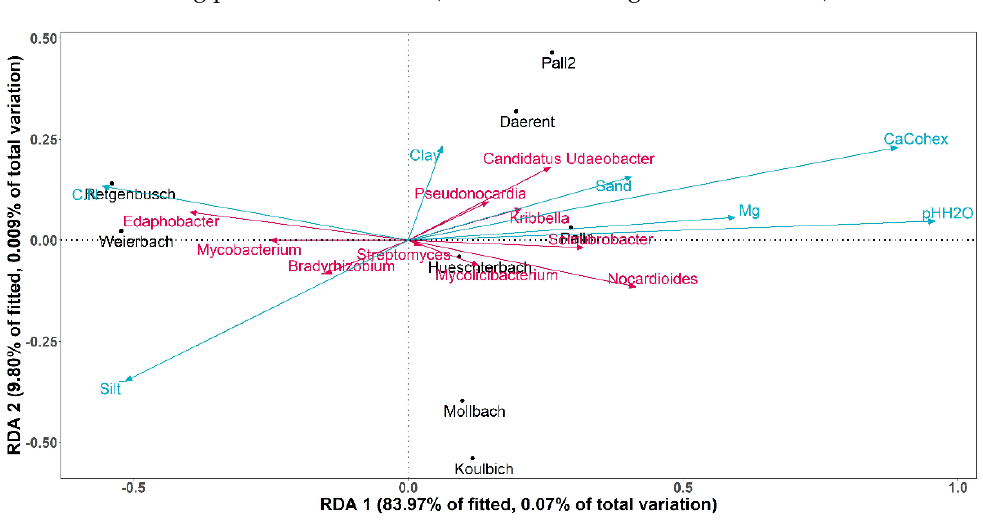
Figure 6. Biplot of redundancy analysis (RDA) on the 10 most abundant genera of bacteria in relation to the soil properties of each site. The pink vectors represent the bacterial genera, the blue vectors display the selected soil properties and the sites are shown in black. The RDA was built over the two first dimensions, with 83.97% of the fitted variations explained by RDA1 and 9.80% by RDA2. (C.N = carbon to nitrogen ratio; Mg = magnesium content; pHH 2 O = soil pH measured in water, CaCohex = calcium cation available).